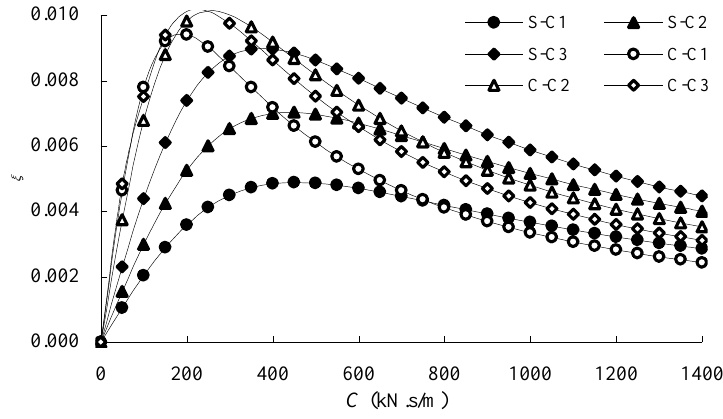
Figure 10. Effects of external dampers on modal